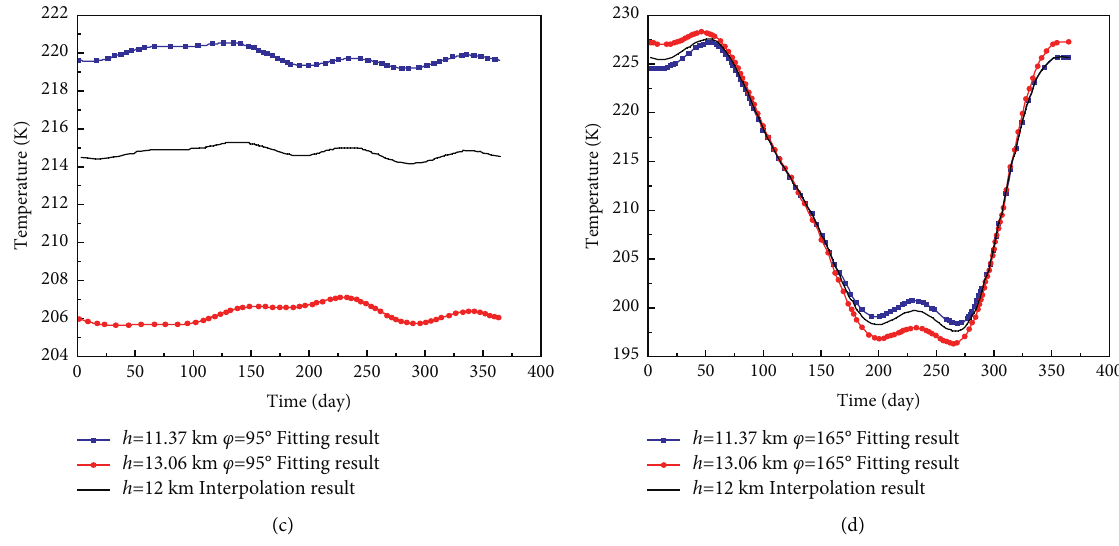
Figure 3: Variation of temperature with time at typical global latitudes. (a) Latitude is 5 ° ; (b) latitude is 55 ° ; (c) latitude is 95 ° ; (d) latitude is 165 °